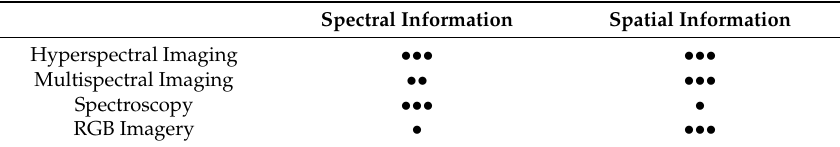
Table 1. Main differences between hyperspectral and multispectral imaging, spectroscopy and RGB imagery (merging perspectives of [43,44]). A classification based on a bullet rate (1–3) was used to quantify both the spectral and spatial information associated to each acquisition technique, in relative terms.